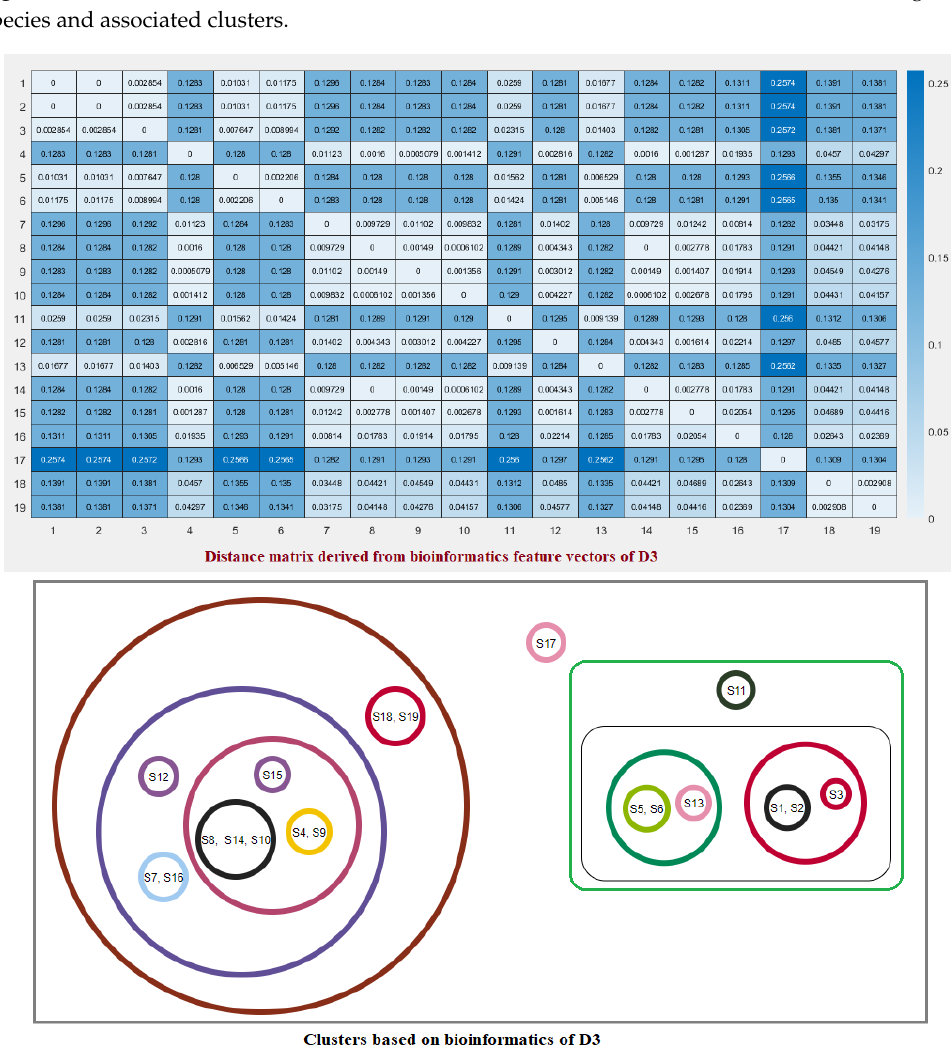
Figure 9. Distance matrix based on the bioinformatics feature vectors of D3 of ACE2 across nineteen species and associated